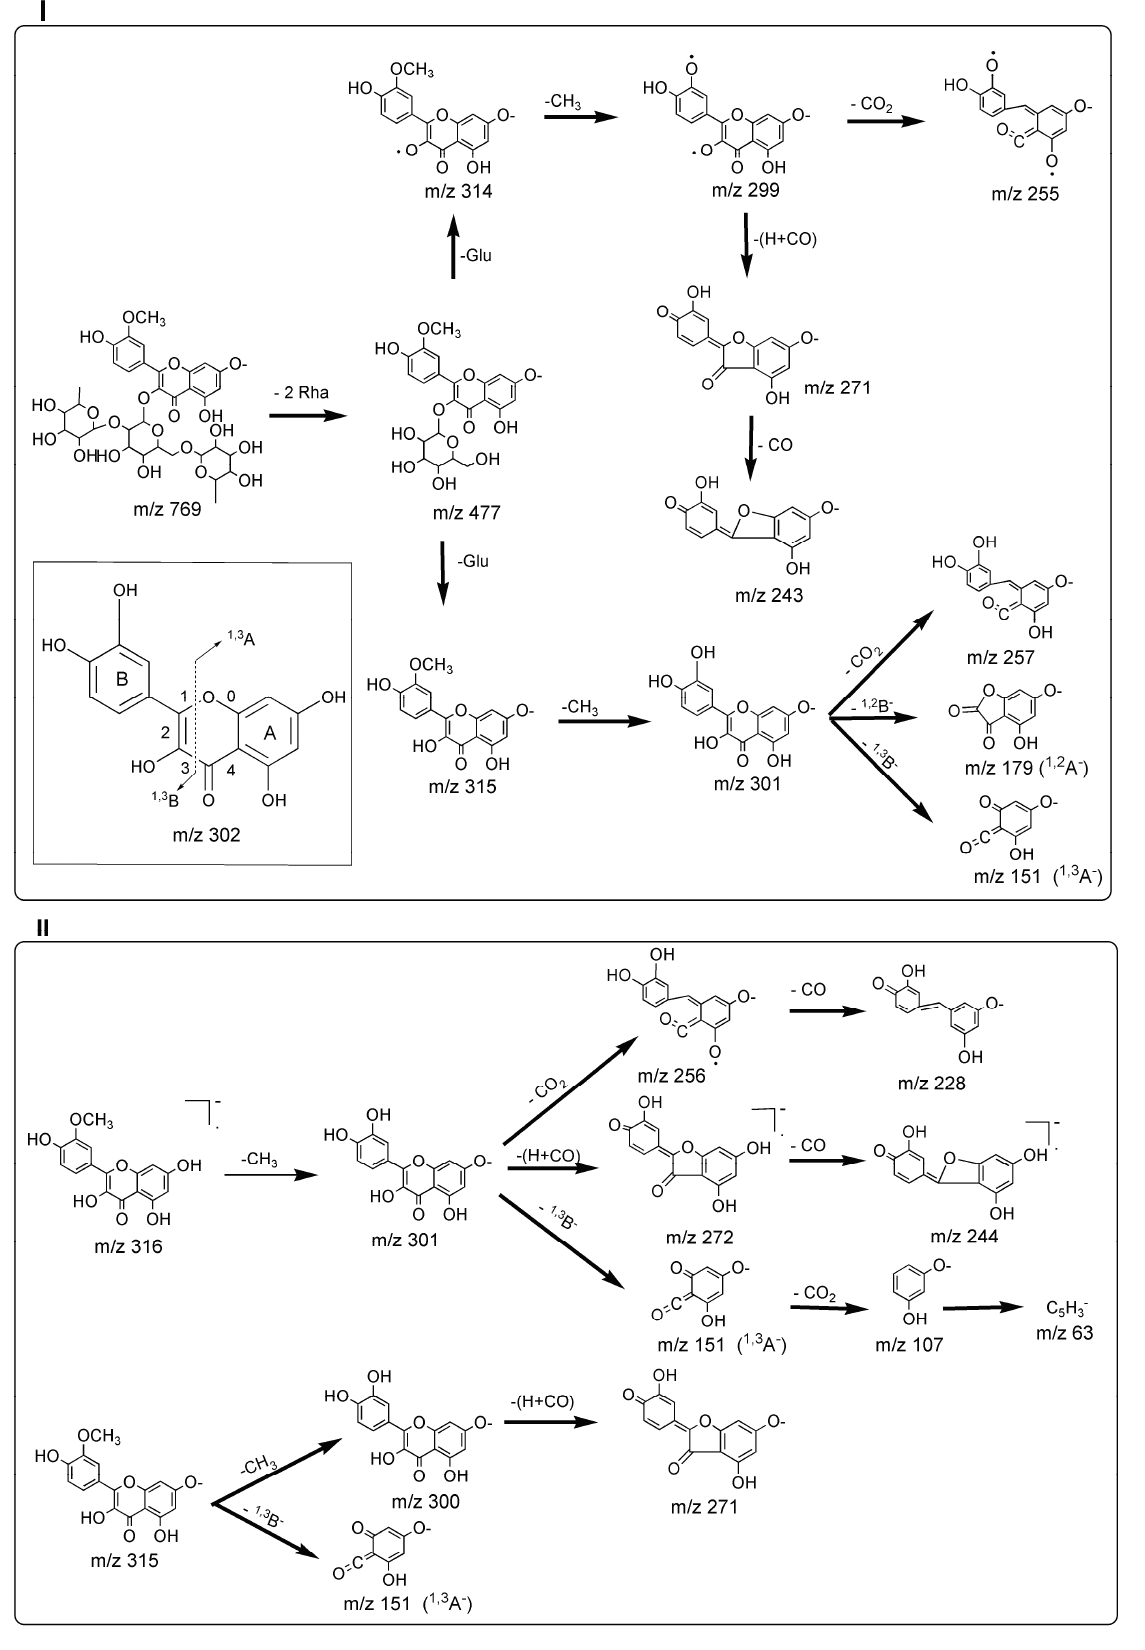
Figure 1. Fragmentation pathways of flavonol-3- O -glycoside (typhaneoside, I ) and its aglycone (isorhamnetin, II ) proposed on the basis of ESI-MS n spectra in negative